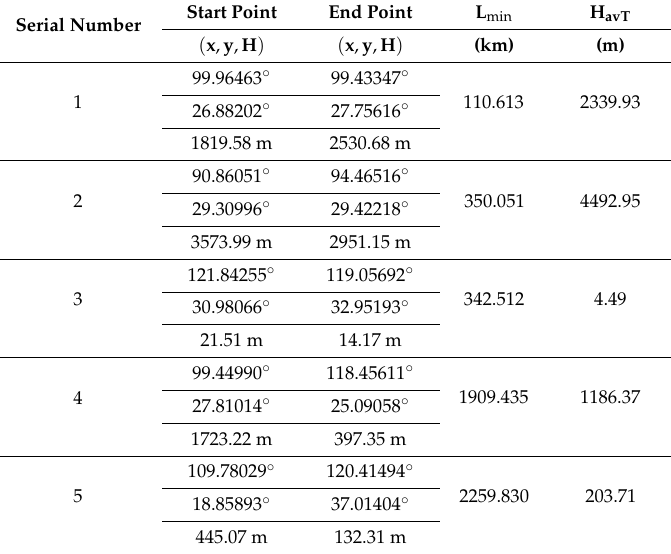
Table 2. Experimental coordinate